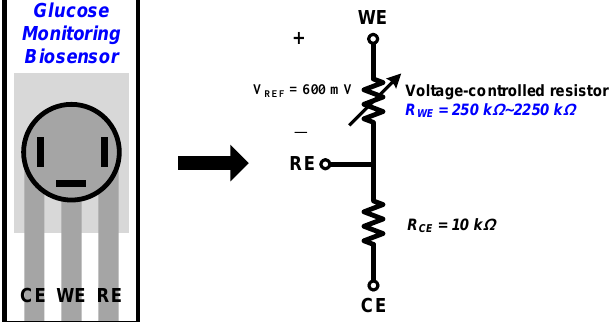
Figure 7. Simplified electrical equivalent model of the glucose monitoring biosensor.